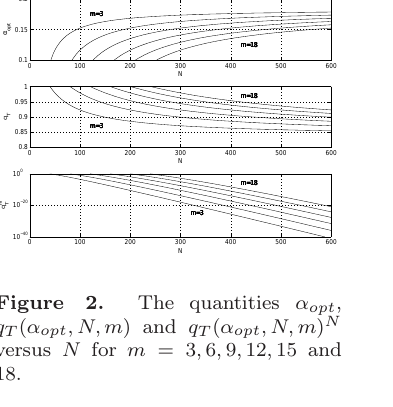
Figure 2. The quantities α opt , q T ( α opt ,N,m ) and q T ( α opt ,N,m ) N versus N for m = 3 , 6 , 9 , 12 , 15 and 18 .